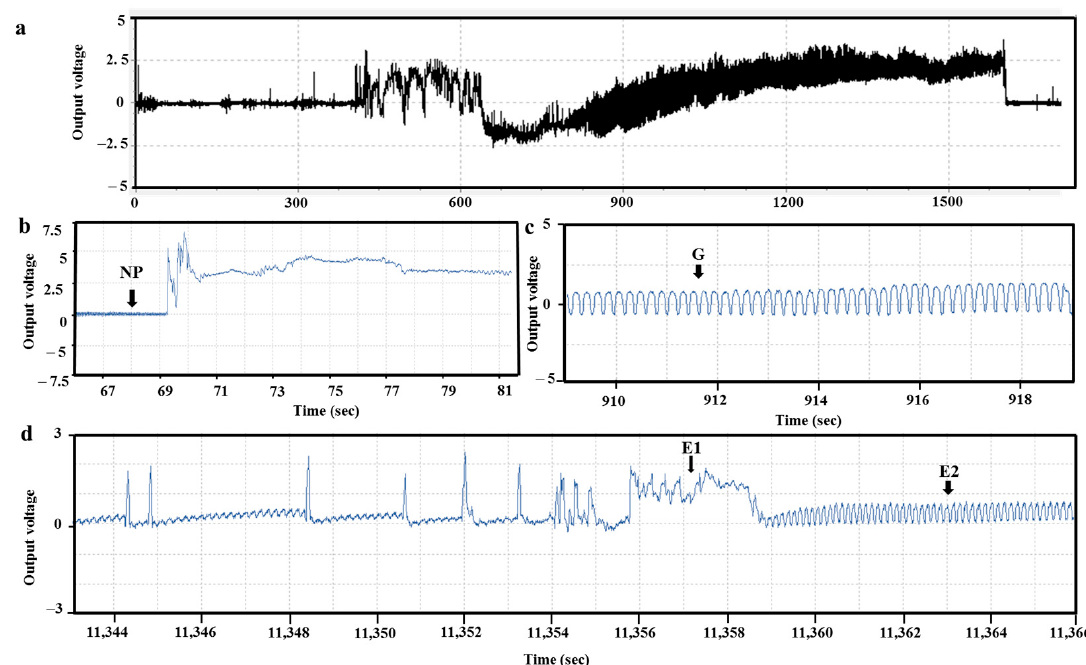
Figure 1. Typical EPG waveform of R. pedestris and H. halys during 1 h of recording and characteristic waveforms (panel ( a )). Panel ( b ) is the NP waveform (non-penetration); panel ( c ) is the G waveform (Xylem feeding phase), and panel ( d ) is the E1 (Salivation) and E2 waveform (Sap feeding phase). The y-axis represents voltage, and the x-axis represents time (s). Table 2. EPG variable values (means ± standard error) during the probing and feeding behavior of R. pedestris and H. halys on six soybean cultivars during a 6-hour recording.